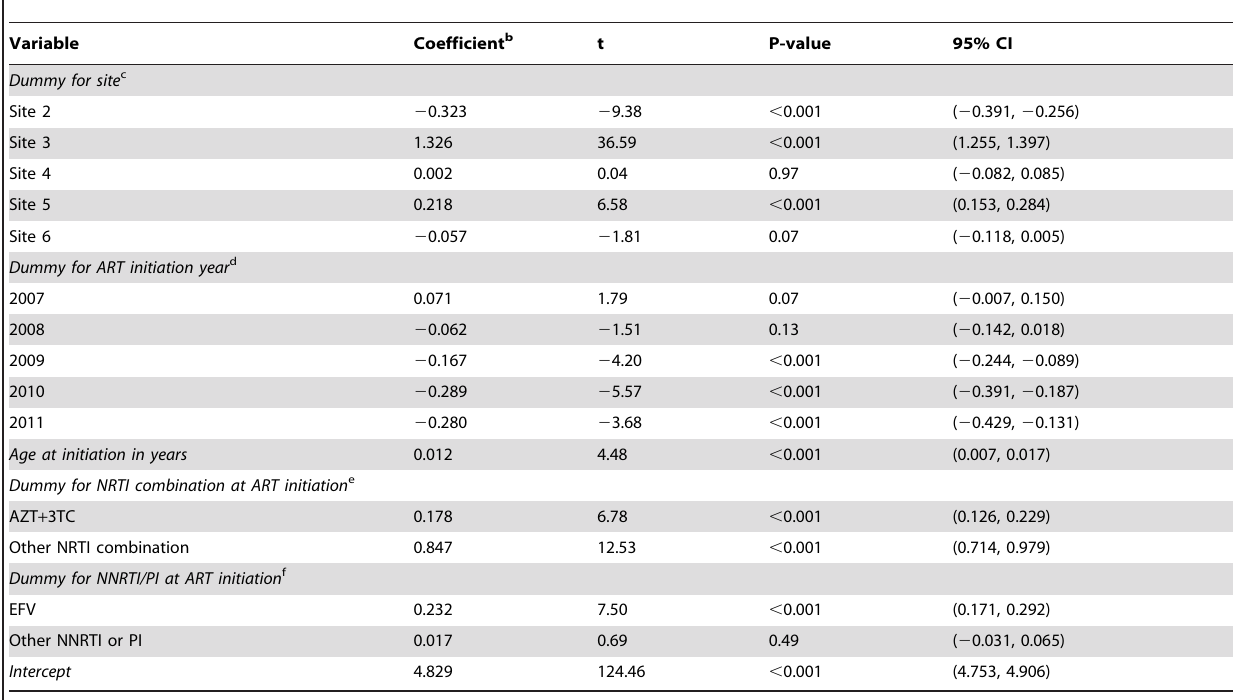
Table 4. Ordinary least squares regression of the natural log of total per patient costs for the first year on ART against study site and patient-specific characteristics a